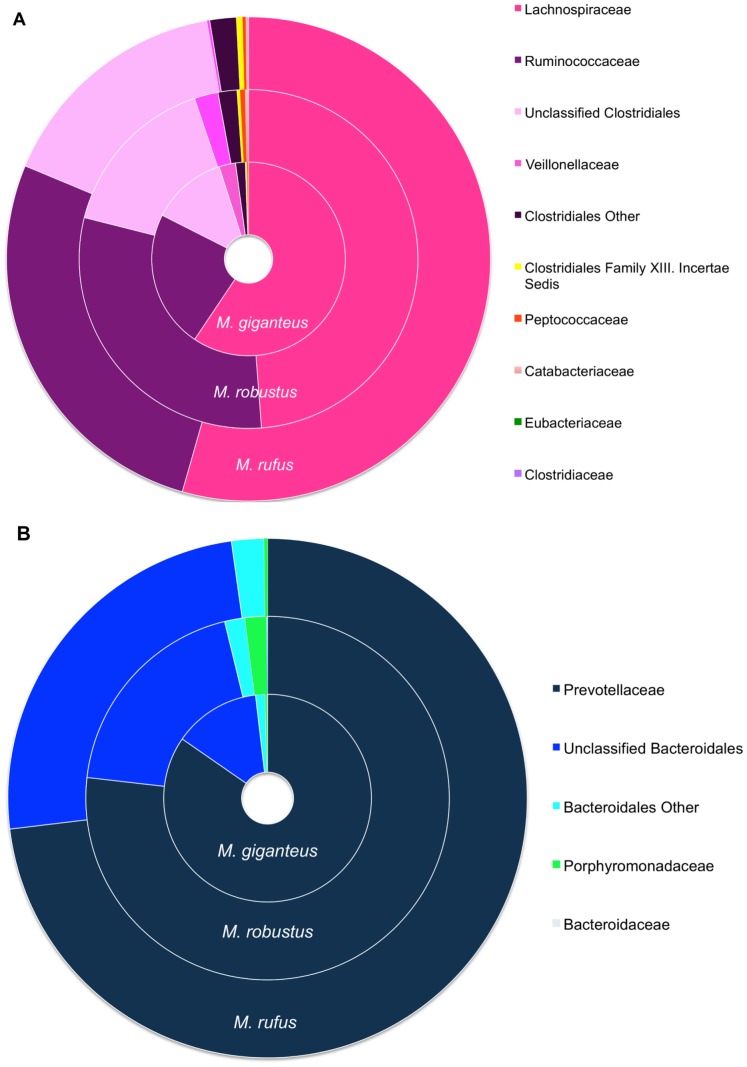
Percent abundance of members of: A) Clostridiales B) Bacteroidales in the foregut of macropods.The percentage abundance of A) Clostridiales B) Bacteroidales identified in the foregut of 20 Queensland macropods using 454-amplicon pyrosequencing.